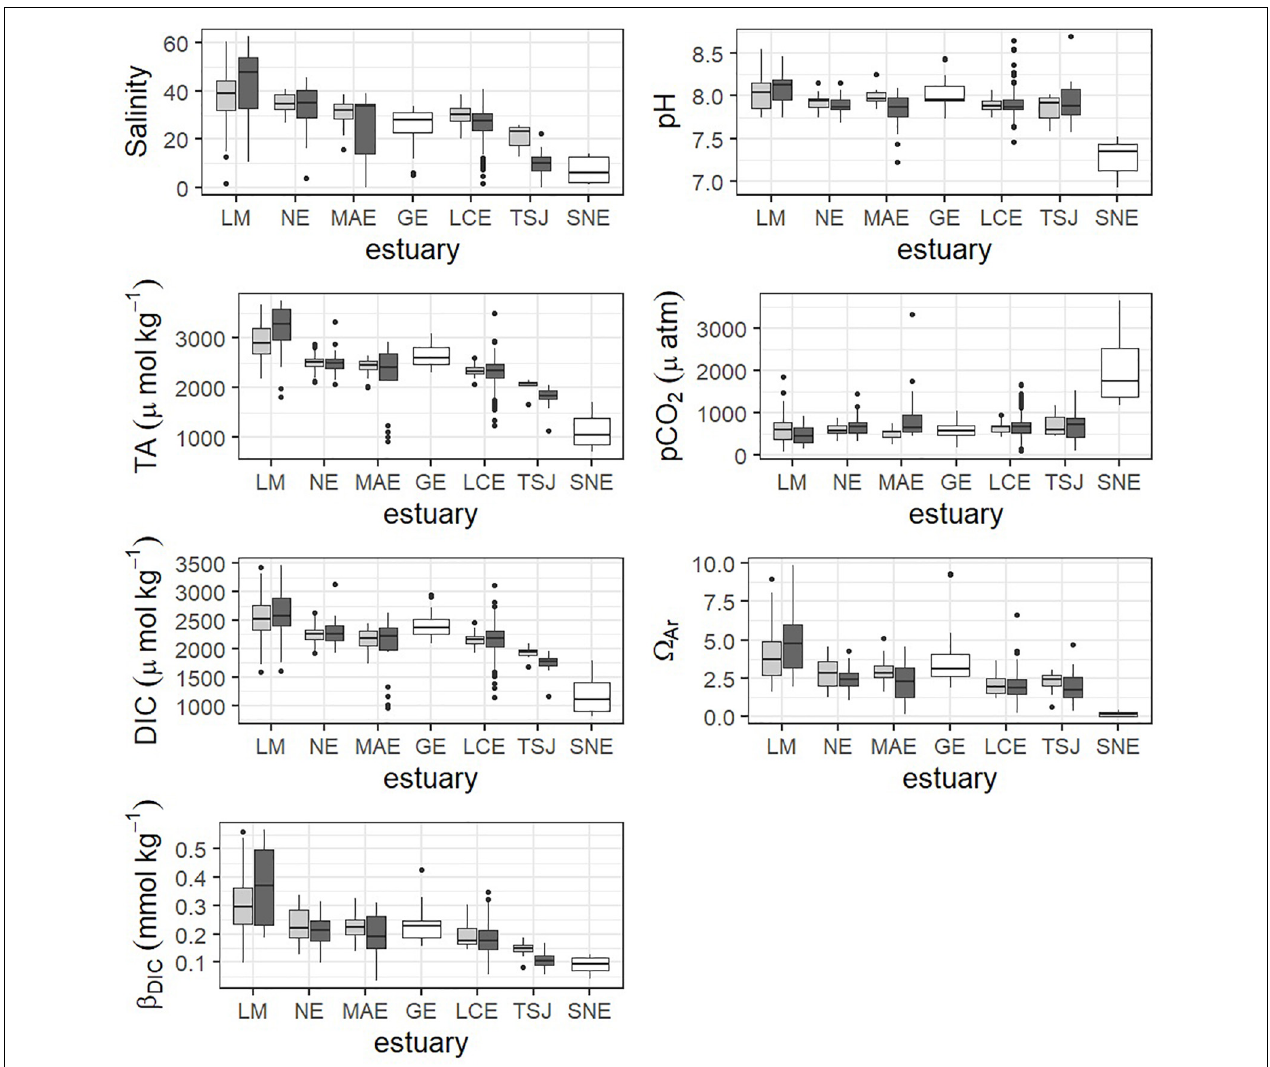
FIGURE 5 | Boxplots showing the distribution of parameters within primary (light gray) and secondary (dark gray) bays within estuaries using the most recent 6 years of data. Estuaries that could not be split into primary and secondary are shown in